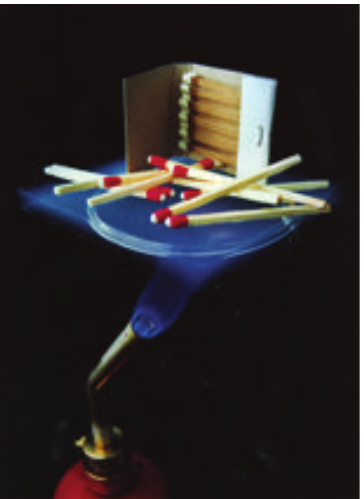
Figure 1: Matches on aerogel over a flame